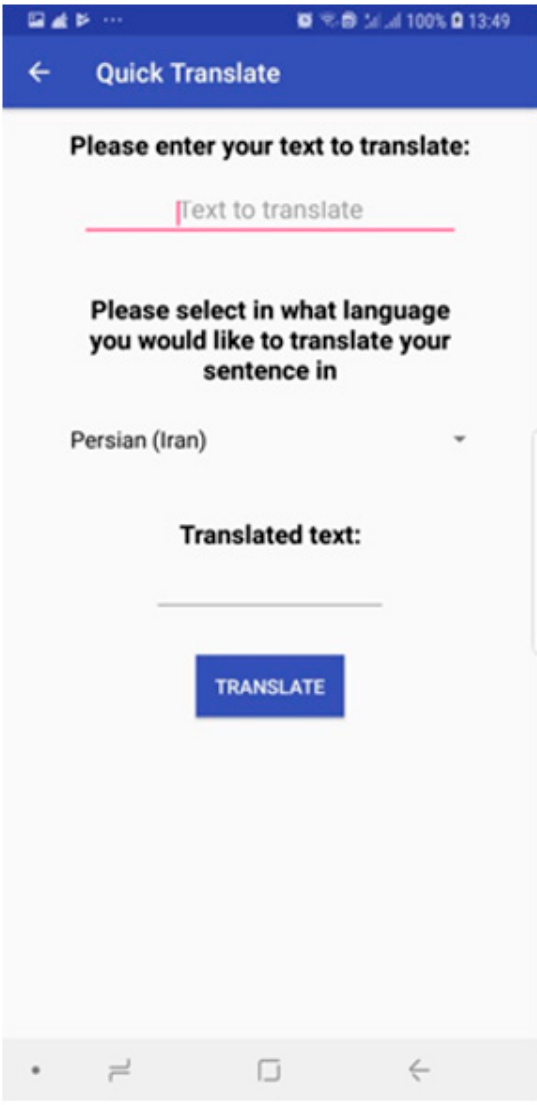
Figure 3. Integrated translation functionality